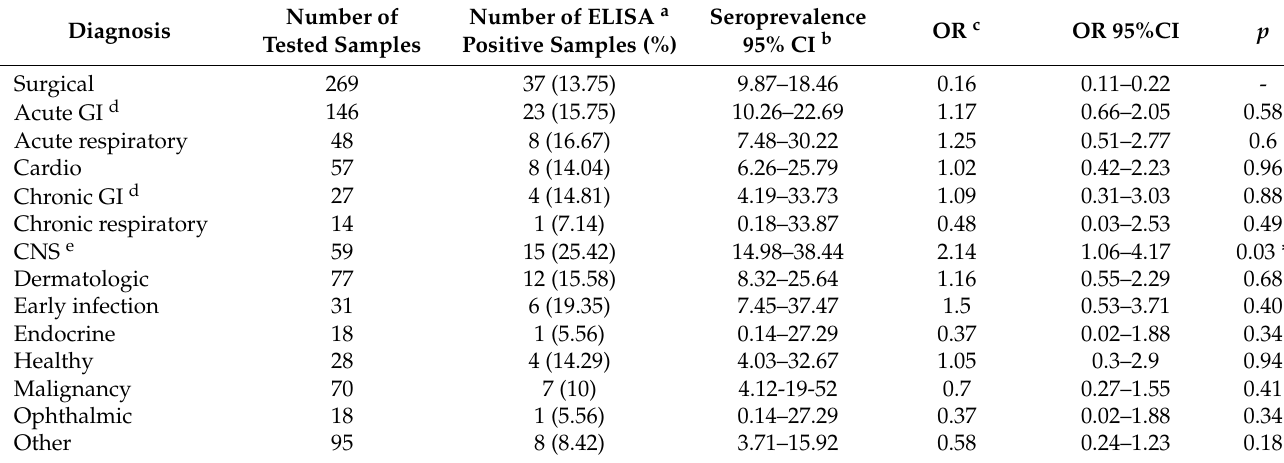
Table 2. Association of the serological status on clinical presentation at the Veterinary Teaching Hospital.